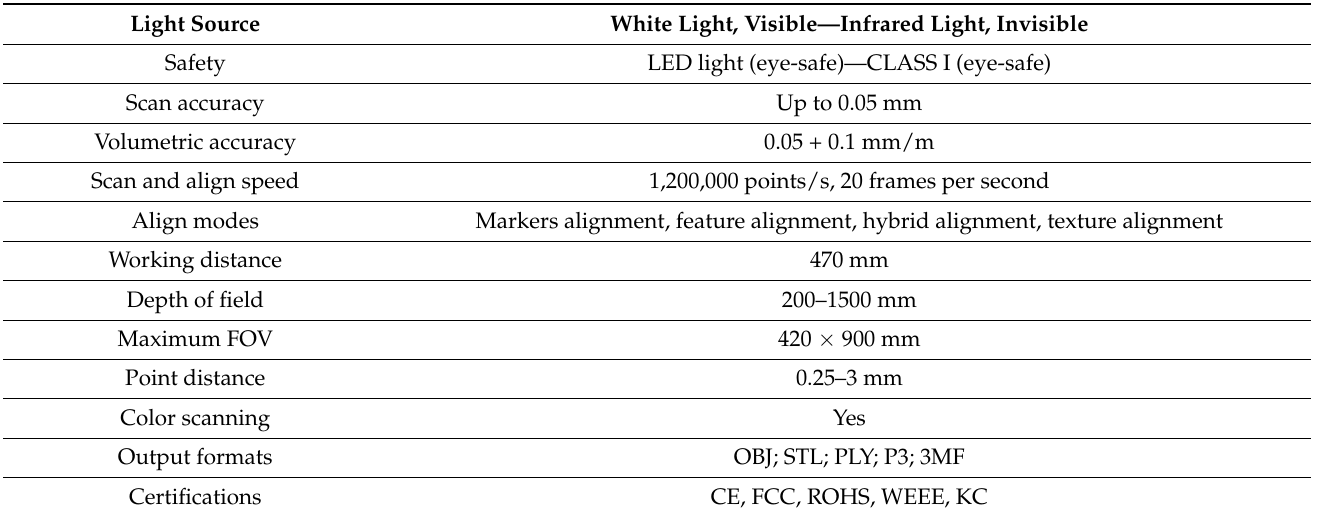
Table 1. Facial scanner technical specifications (Einscan H—Shining 3d—www.einscan.com, accessed on 7 September 2022).